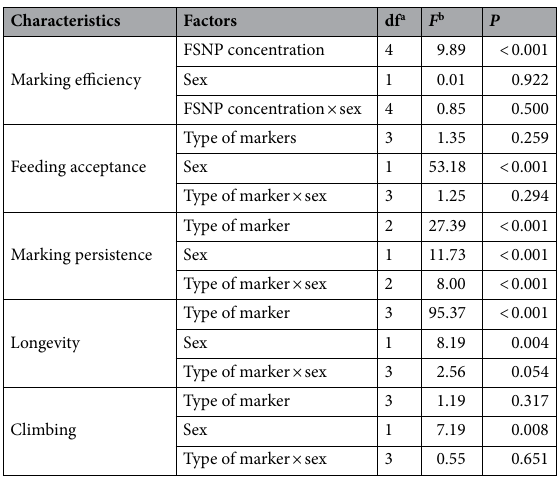
Table 1. Effects of markers, sex, and their interaction on marking parameters and characteristics of Drosophila melanogaster , using the aligned rank test. a df is the degrees of freedom. b F is the F-statistic, which is the ratio of the mean sum of squares to the mean square error.